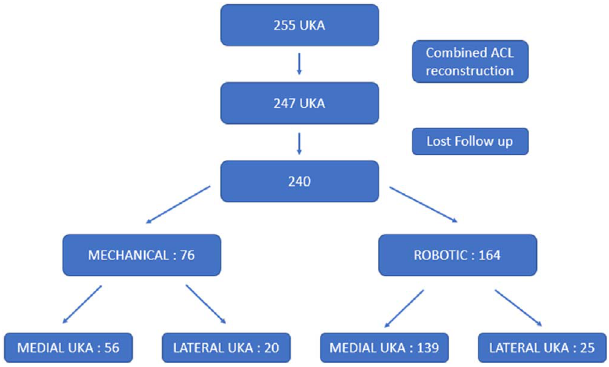
Figure 1. Flowchart.